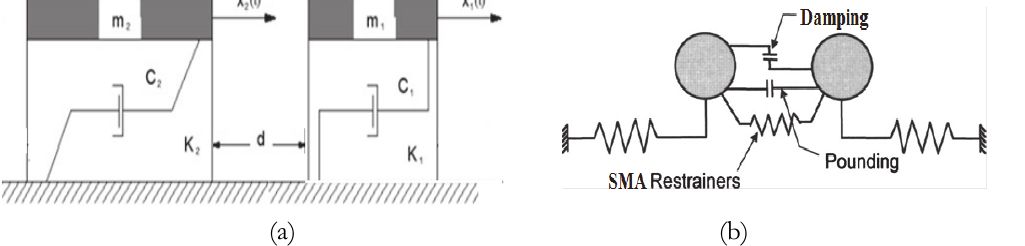
Figure 2: A bridge with two adjacent frames, (a) Schematic diagram of two adjacent SDOF systems; (b) A Simplified model of 2-DOF